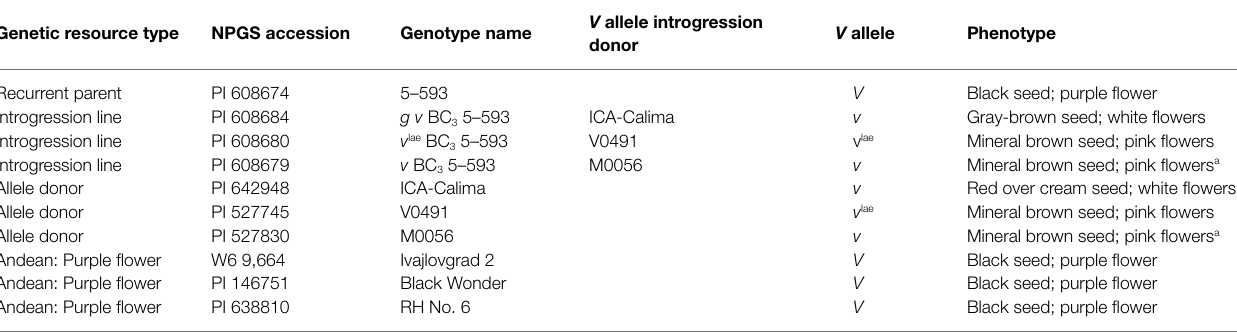
TABLE 1 | Genetic resources used in V and flavonoid 3 ′ 5 ′ hydroxylase mapping and sequencing experiments. Genetic resource